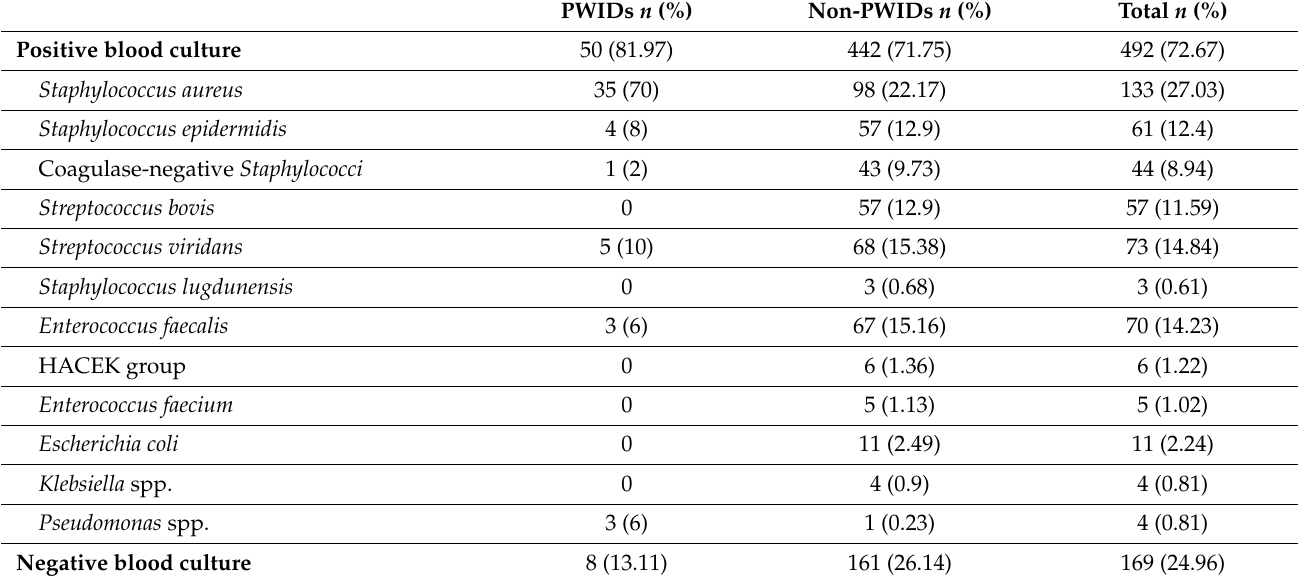
Table 2. Blood culture results and microorganisms isolated in positive blood cultures. PWIDs n